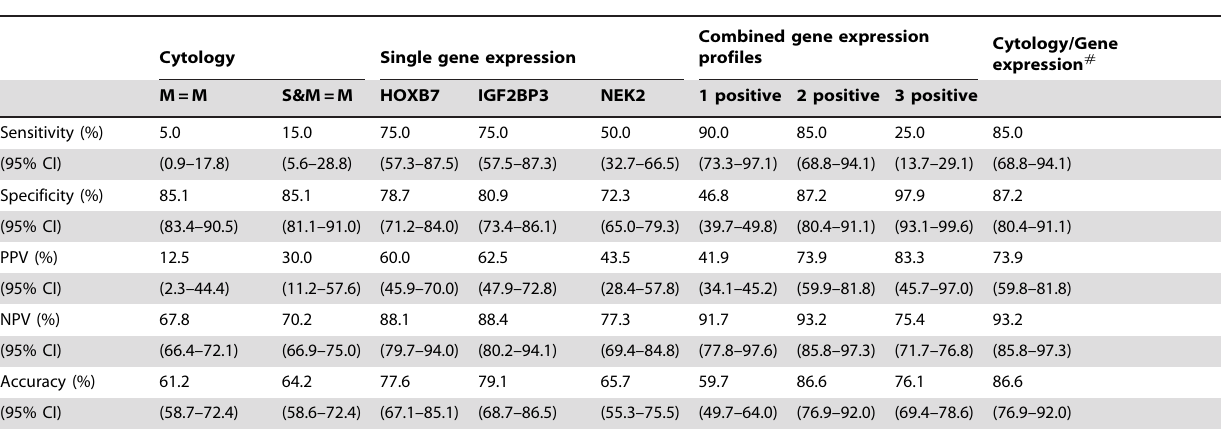
Table 6. Performance Characteristics for Patients with Pancreatic Cancer